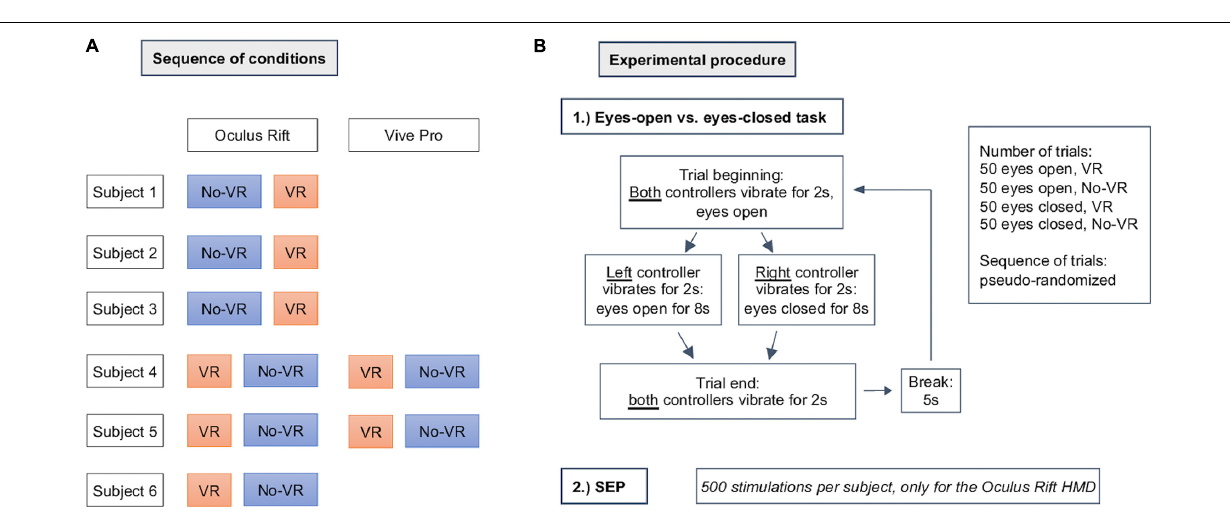
FIGURE 2 | Experimental procedure: (A) shows the sequence of the conducted experiments and which HMD was used. In (B) , the procedure of a single subject is shown and how the different conditions were